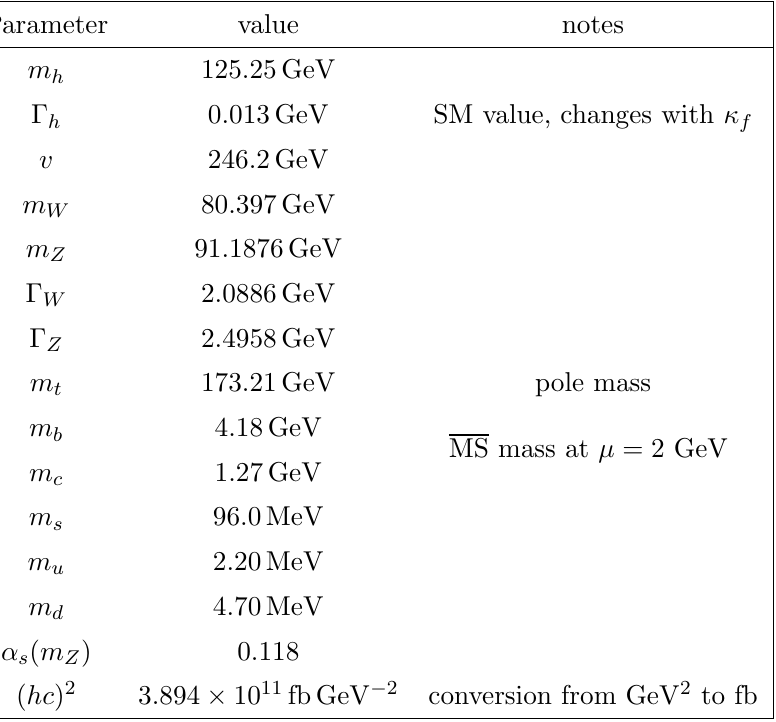
Table 6 . The input parameters used in this work, all taken from the PDG